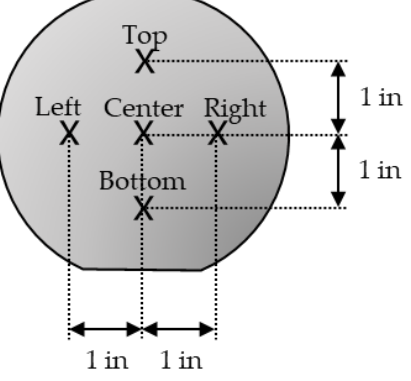
Figure 1. Locations of film thickness